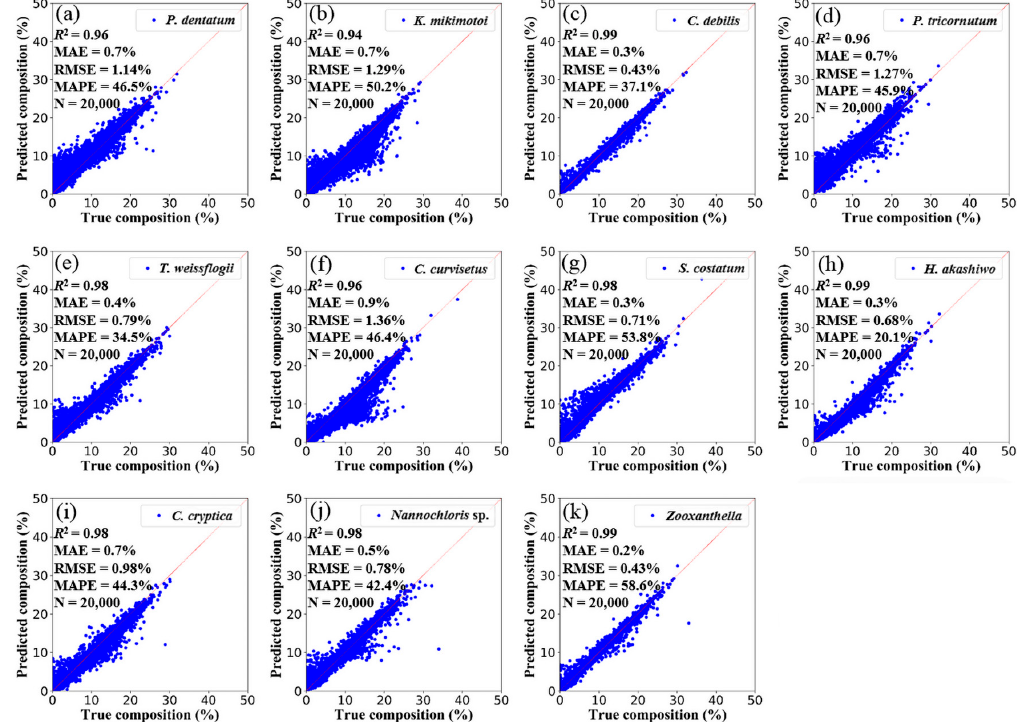
Figure 5. The NN sim -predicted compositions versus the true compositions of 11 phytoplankton species in the randomly selected 10% of the simulation dataset (there are 20,000 spectra). Namely, ( a ) P. dentatum , ( b ) K. mikimotoi , ( c ) C. debilis , ( d ) P. tricornutum , ( e ) T. weissflogii , ( f ) C. curvisetus , ( g ) S. costatum , ( h ) H. akashiwo , ( i ) C. cryptica , ( j ) Nannochloris sp., ( k ) Zooxanthella . The solid line is the 1:1